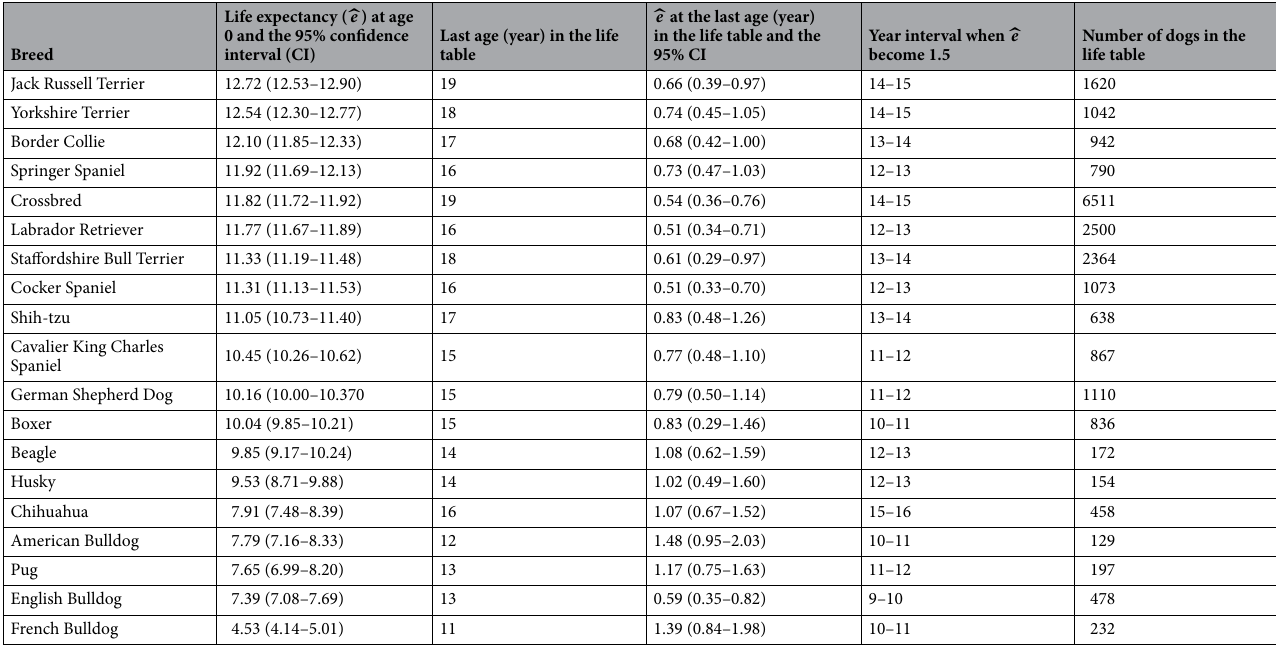
Table 3. Key statistics extracted from the life tables of 18 individual dog breeds and of crossbred, including the life expectancy at age 0 and at the last age, using the data of dogs under primary veterinary care in the